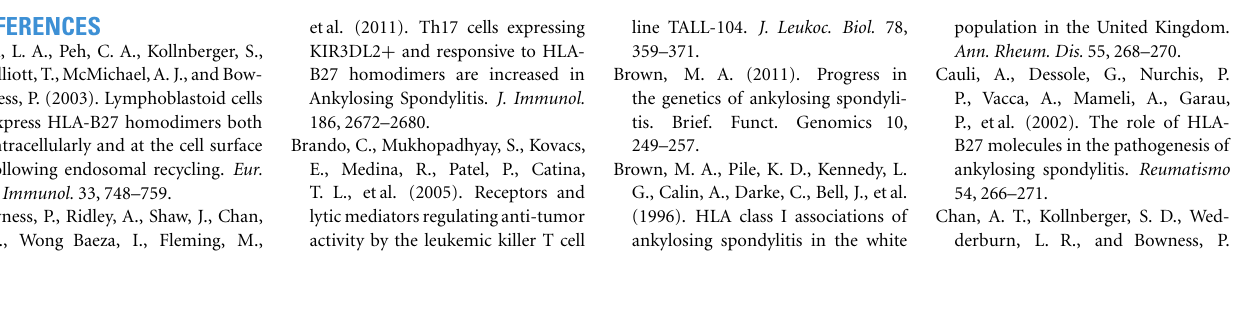
FIGURE 1 | Hypothetical role of KIR3DL2 ligand interactions in inflammation. KIR3DL2 is expressed as a disulphide-bonded dimer with D0, D1, D2 immunoglobulin-like domain organization and two cytoplasmic ITIM motifs. (1) KIR3DL2 expression is induced byT cell activation and/or NK differentiation. (2) Bacterial infection may promote formation of B27 dimers (B27 2 ) and free heavy chains (FHC) by enhanced recycling of β 2m-associated HLA class 1 by antigen presenting cells (APC). (3) B27 FHC including B27 2